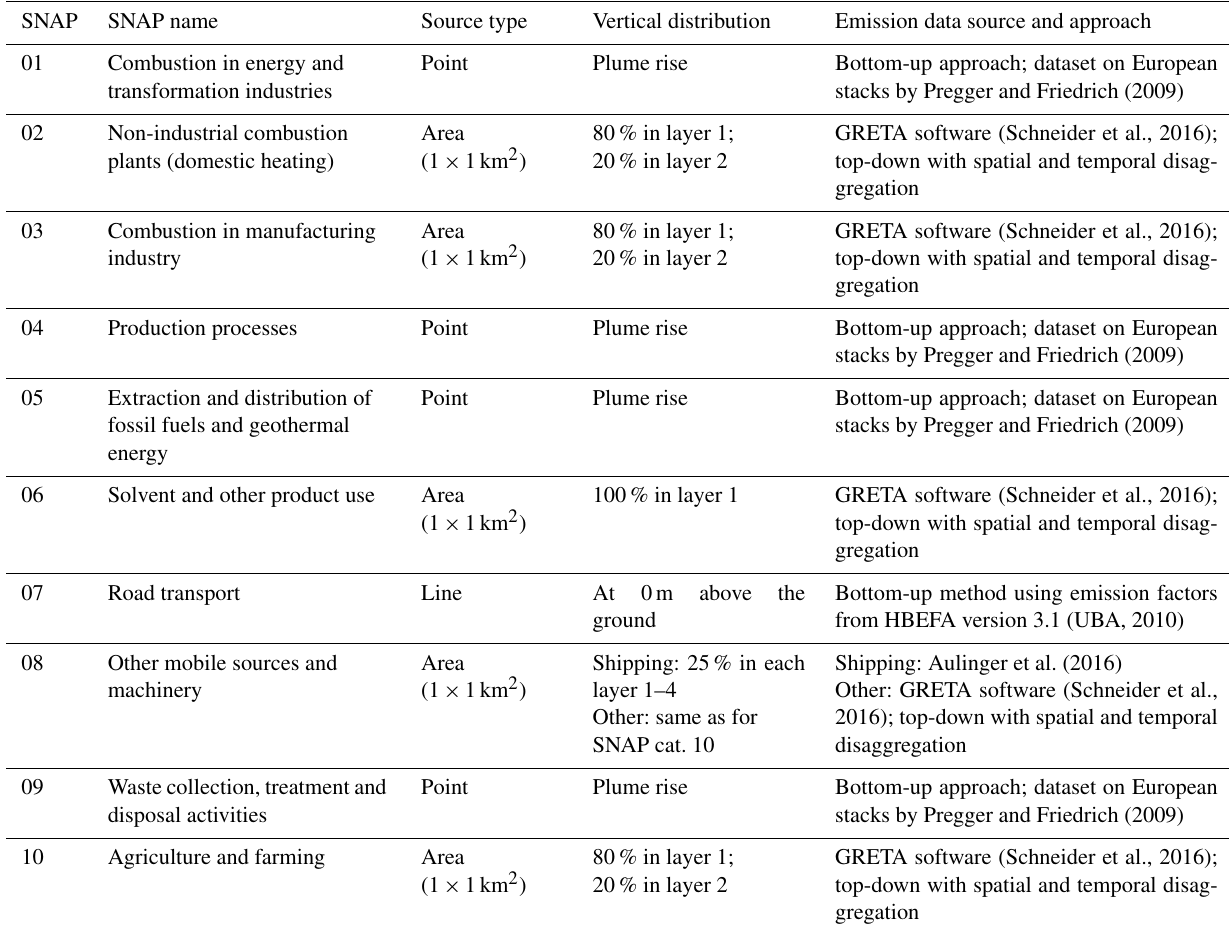
Table 6. Emission sector data for the simulation of air quality in Hamburg. Classification according to Selected Nomenclature for sources of Air Pollution (SNAP). The top heights of layers 1, 2, 3 and 4 are 17.5, 37.5, 62.5 and 87.5m above the ground, respectively. Point source emission data for SNAP categories 01, 04, 05 and 09 were collected from the PRTR database (PRTR, 2017) and from the registry of emission data for point sources in Hamburg as reported under the German Federal Emission Control Act